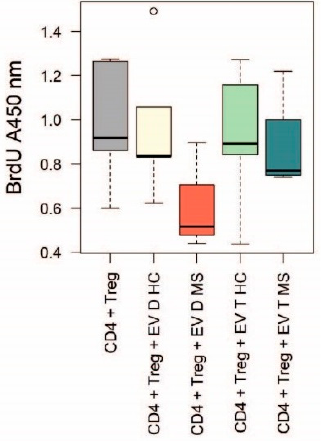
Figure 5. BrdU cell proliferation assay on co-cultures of CD4 + T cells activated via CD3/CD28 and CD4 + CD25 + CD127 dim/ − Tregs conditioned or not with EVs. Kruskal–Wallis test, p = 0.44.